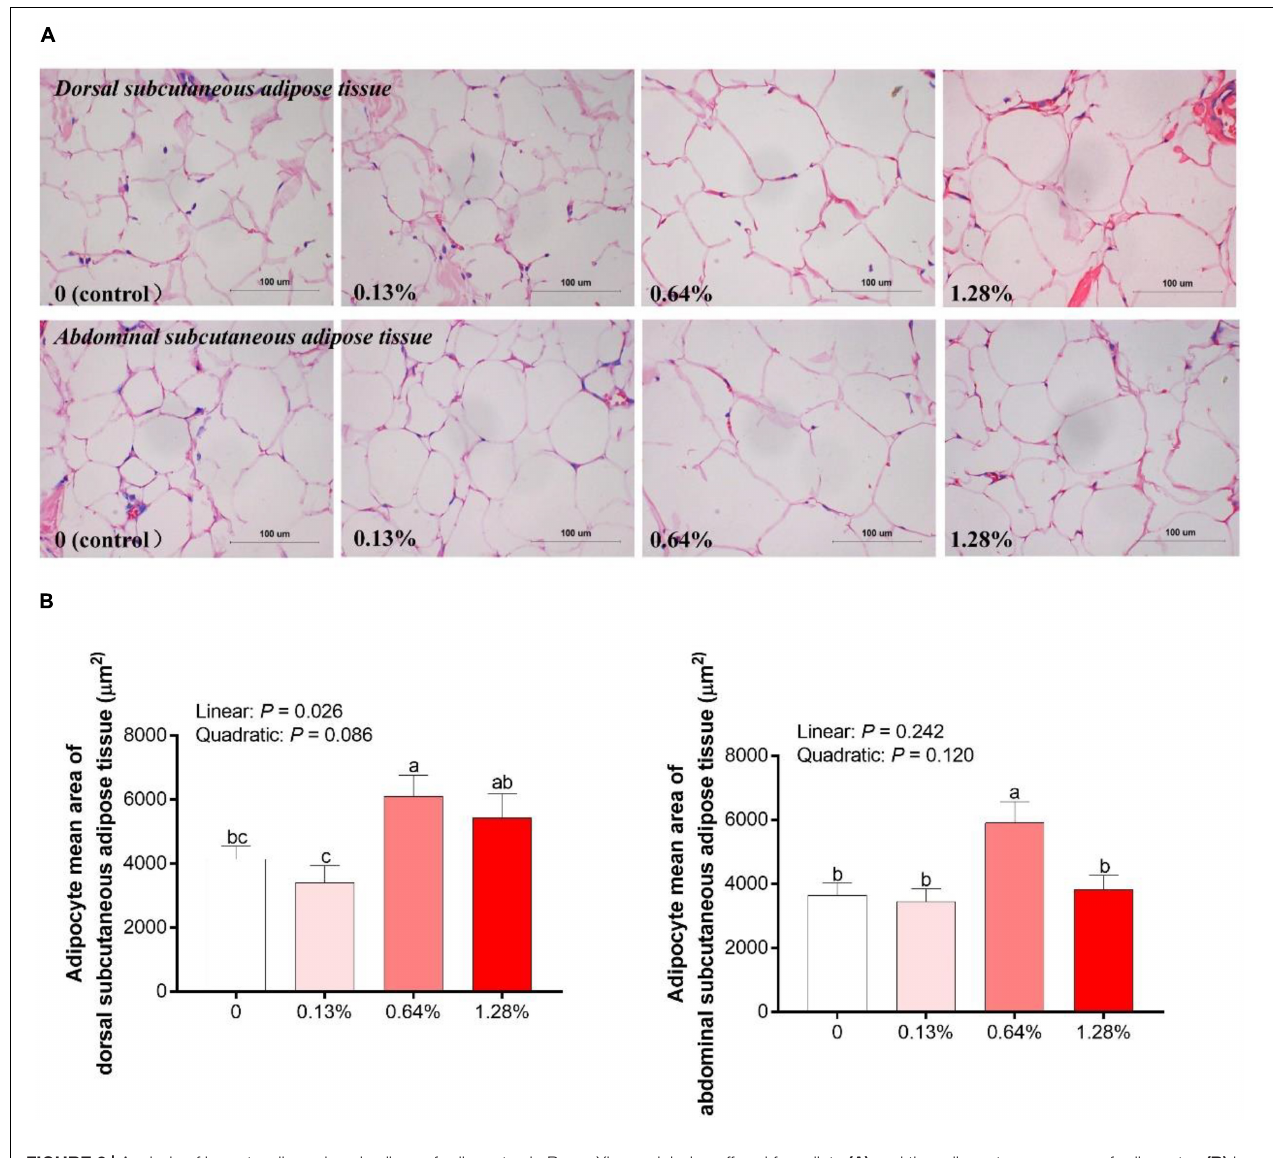
FIGURE 2 | Analysis of hematoxylin and eosin slices of adipocytes in Bama Xiang mini-pigs offered four diets (A) and the adipocyte mean area of adipocytes (B) in the adipose tissue of Bama Xiang mini-pigs. Data are presented as mean ± SEM ( n = 8). a , b , c Values with different letters are significantly different among dietary HMB treatments ( P <